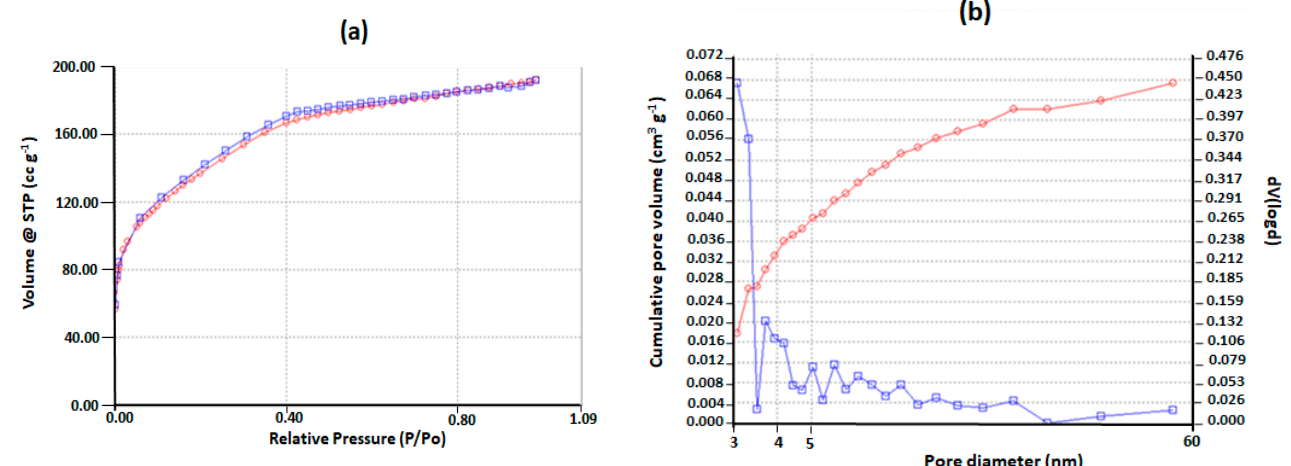
Figure 1. ( a ) Nitrogen adsorption (red line)—desorption (blue line) isotherms, ( b ) pore size distribution of empty mesoporous silica particles (MSPs) (blue line) and cumulative pore volume (red line).